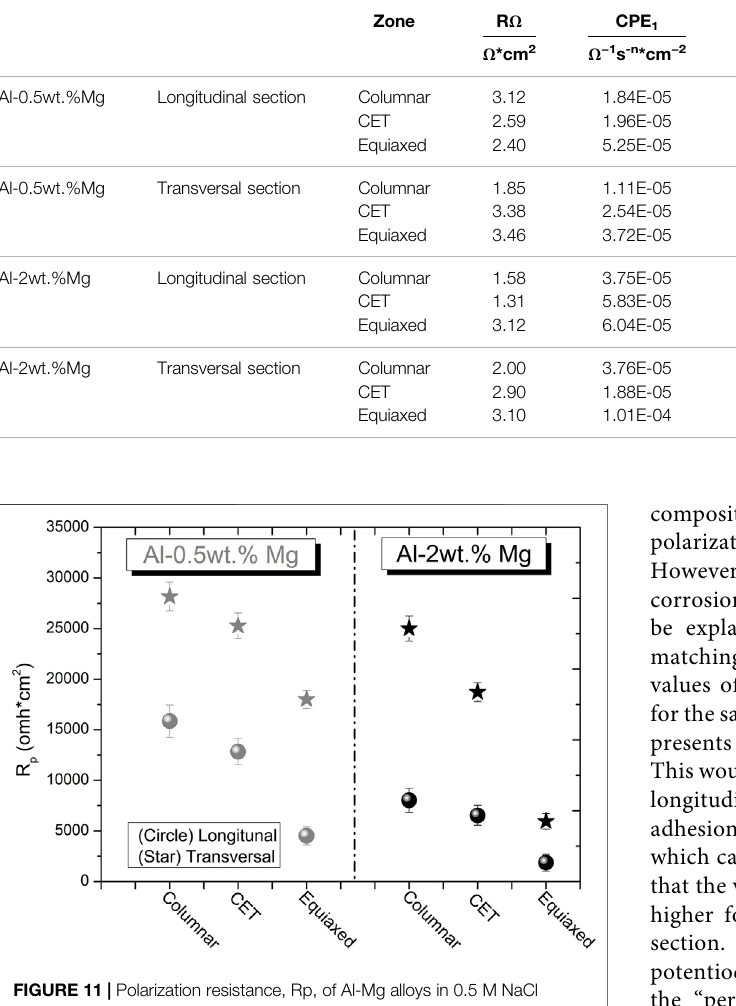
TABLE 3 | Electrochemical impedance spectroscopy fi tting parameters.